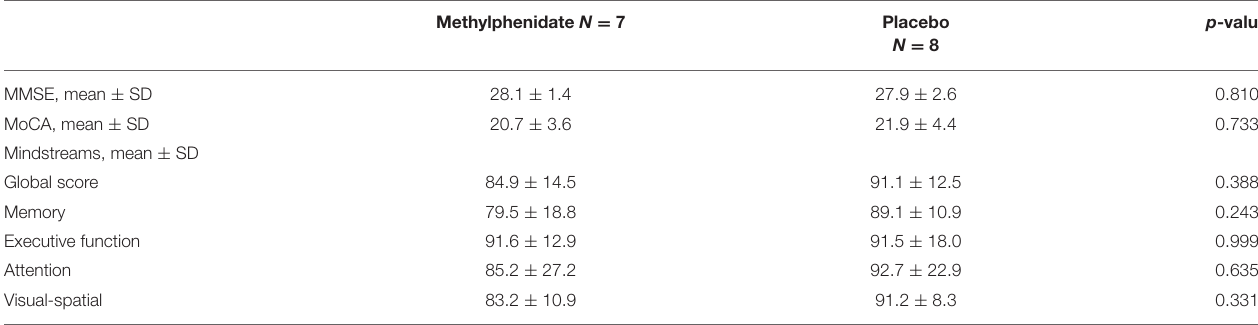
TABLE 2 | Baseline cognitive assessment.